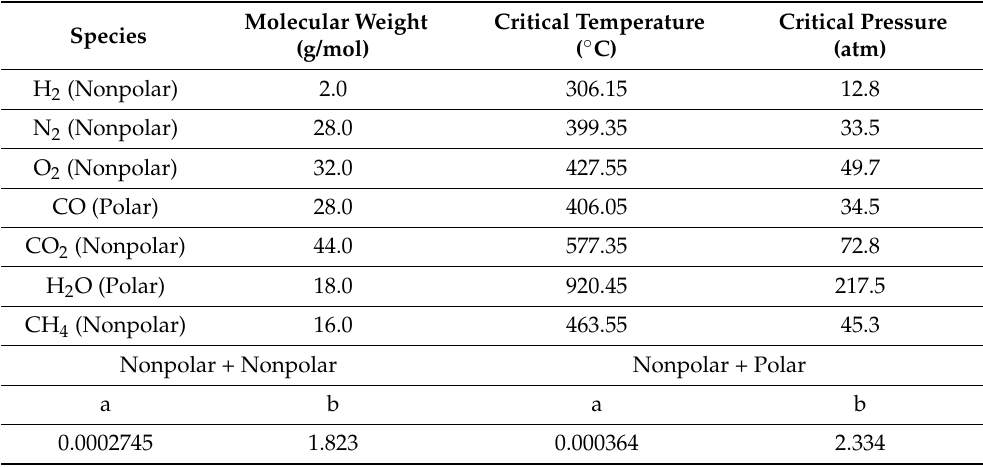
Table A2. Molecular weight, critical temperature, and critical pressure, according to chemical species [18].